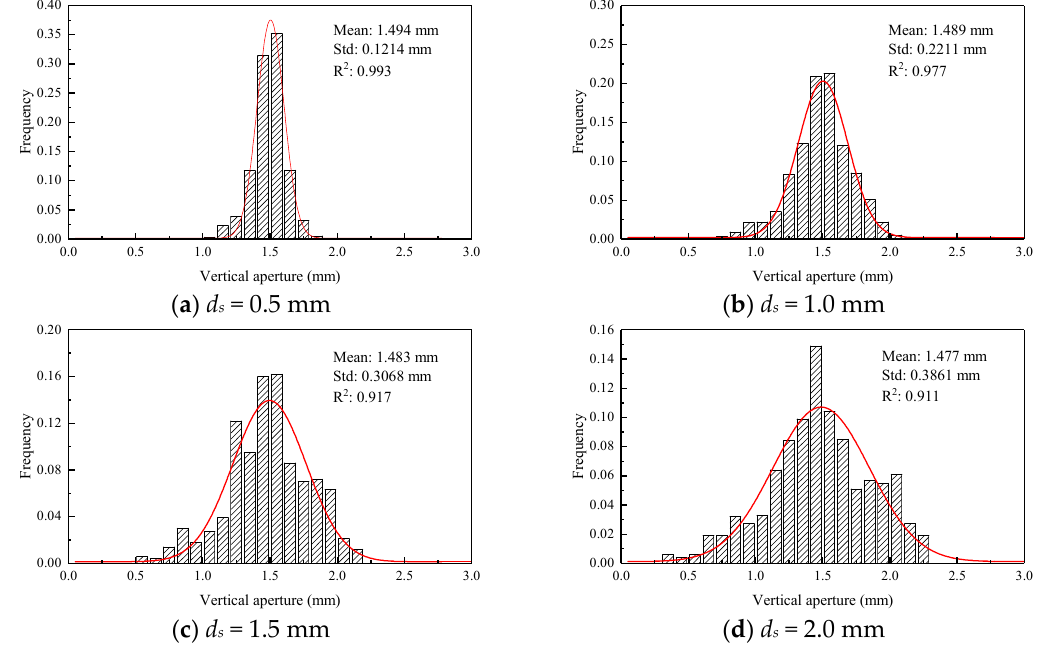
Figure 5. Gaussian distribution and vertical apertures for different shear displacements when JRC = 13.51.